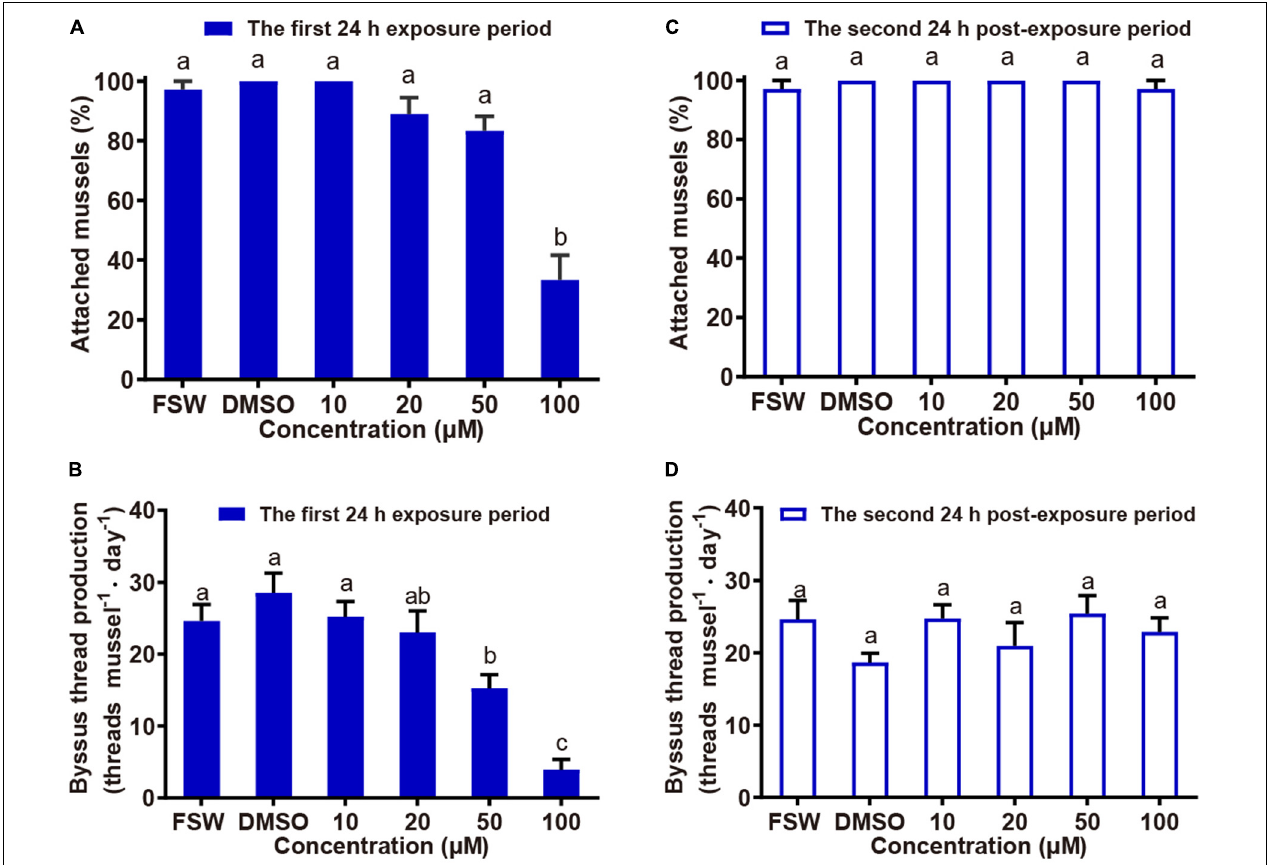
FIGURE 3 | Effect of exogenous 2-AG on attachment of P. viridis . Attachment and byssus thread production of mussels following exposure to 2-AG for a 24 h period (exposure effect) and in the absence of 2-AG in the subsequent 24 h post-exposure period (residual effect). FSW: The FSW control. DMSO: The solvent only control (0.5% DMSO in FSW). Different letters above columns indicate significant differences ( P < 0.05). Data shown are means + SE of replicates ( n = 3 for attachment percentage in (A,C) ; n = 36 for the number of byssus threads in (B,D)